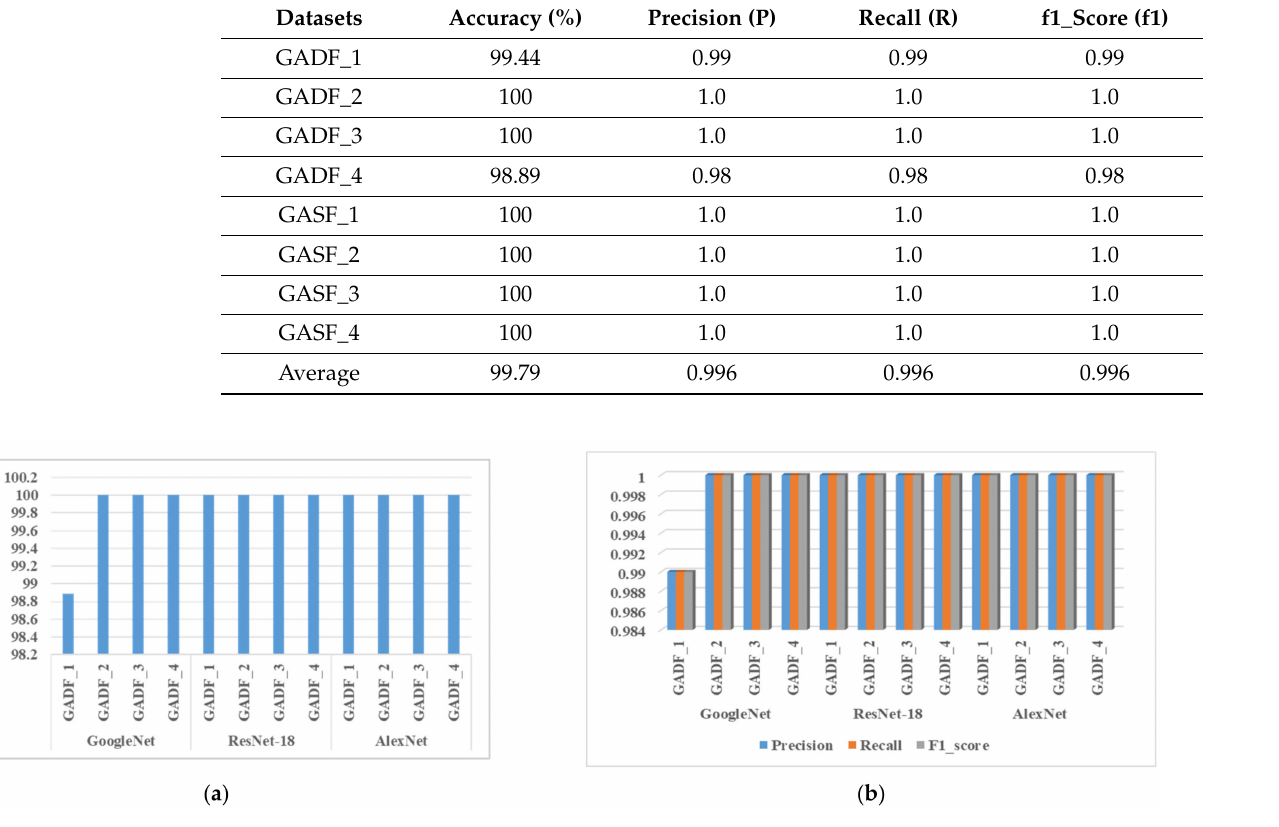
Figure 8. The performance of the three existing models: ( a ) accuracy and ( b ) precision, recall, and F1_score for the four conditioned GADF-encoded